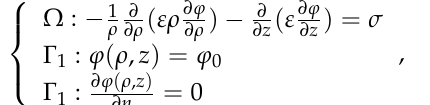
Figure 2. Discrete field with discontinuous circle interfaces.